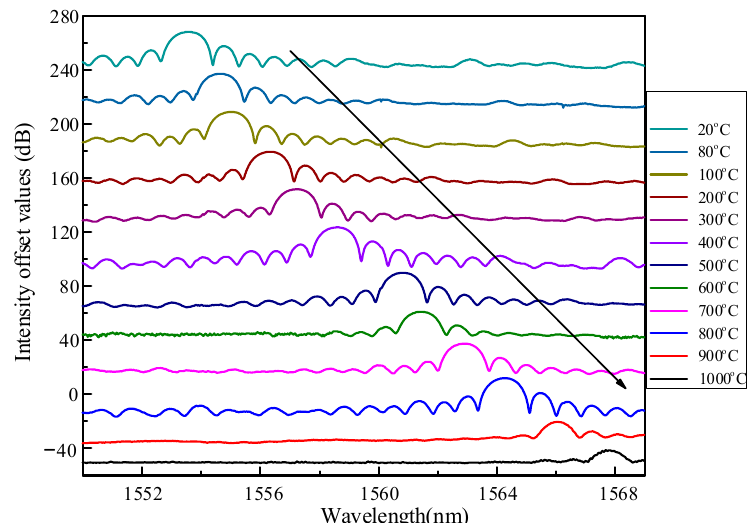
Figure 7. Grating reflection spectrum at different temperatures.